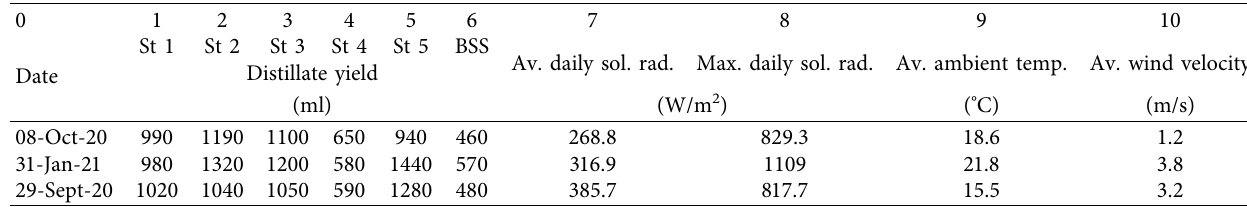
Table 3: Various parameters of the vapour-based MSS-SS under moderate conditions.